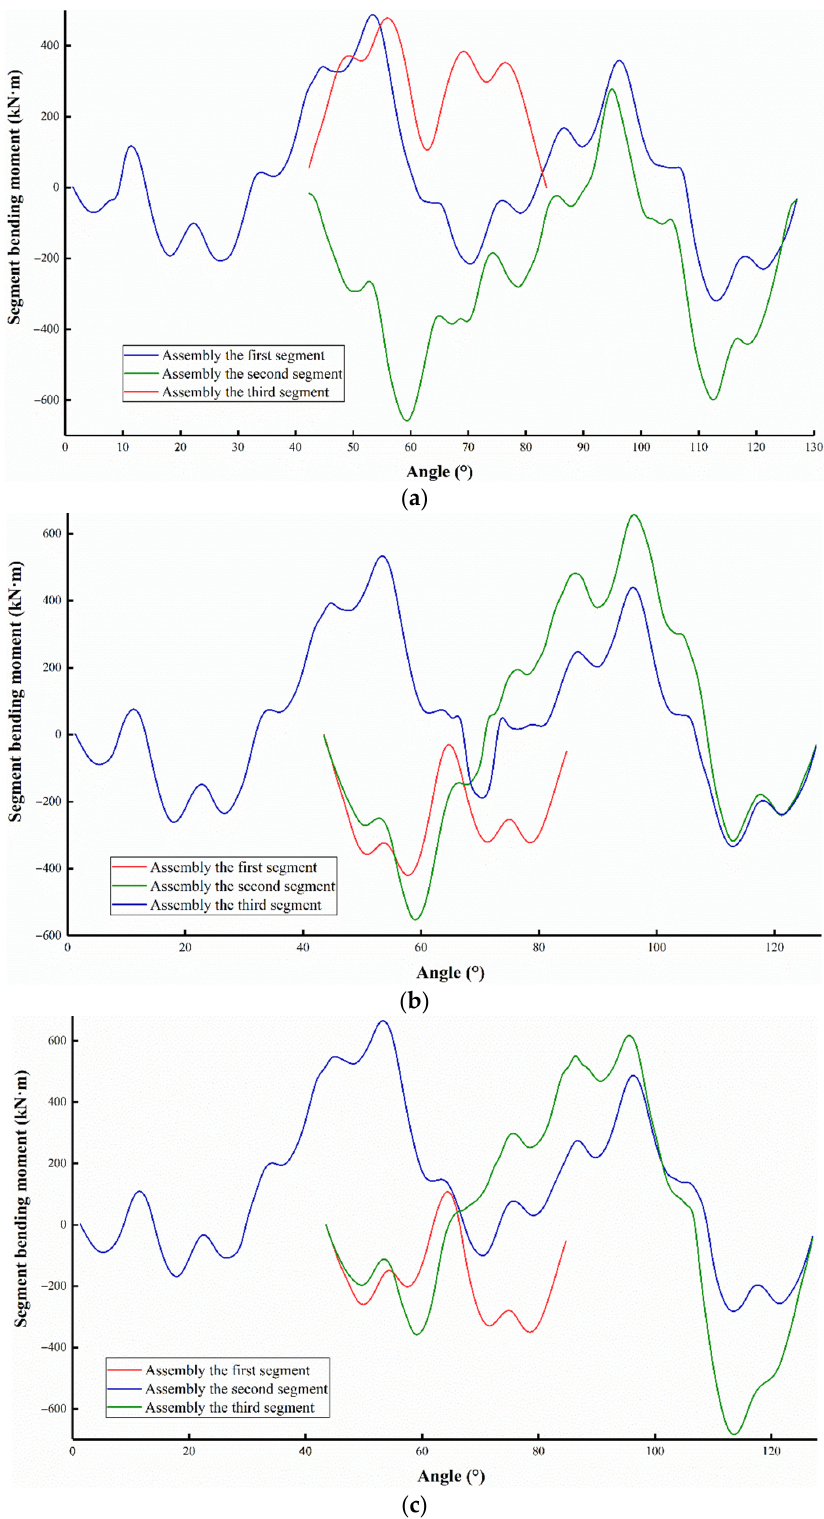
Figure 10. Bending moment in the model: ( a ) the segment at the top; ( b ) the lateral segment; ( c ) the segment at the